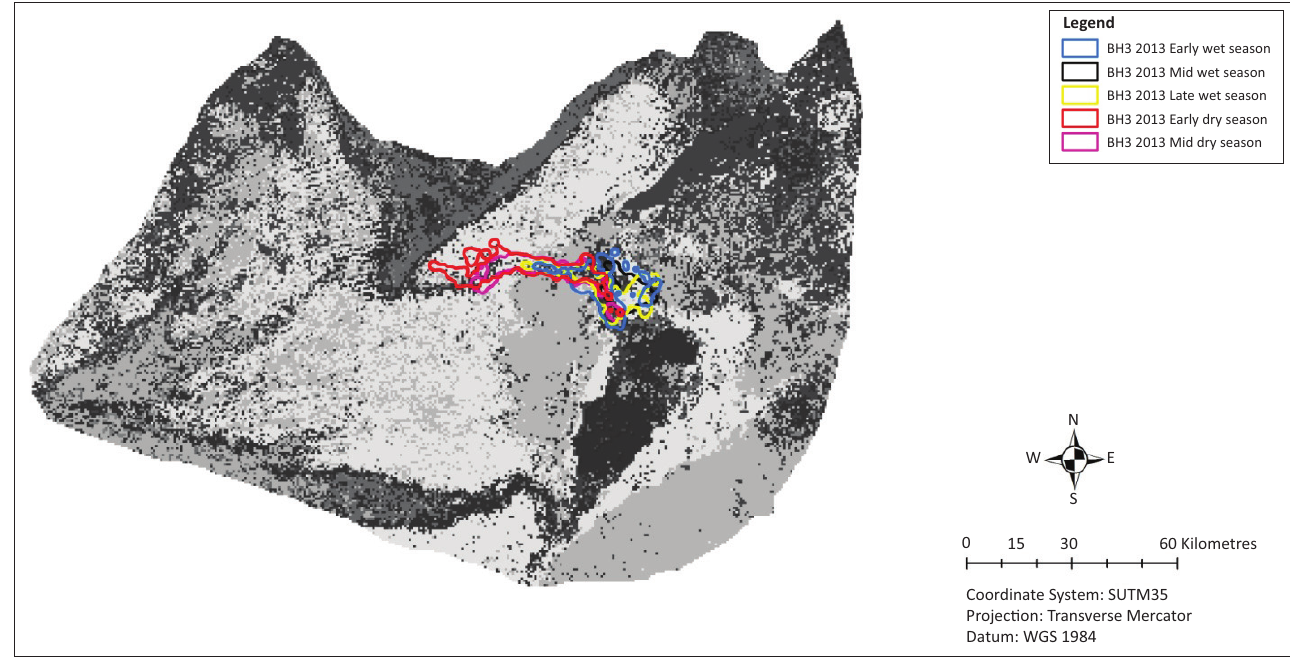
FIGURE 5: Movement patterns of buffalo 3 (BH3) over the 2012/2013 annual cycle, in relation to vegetation.